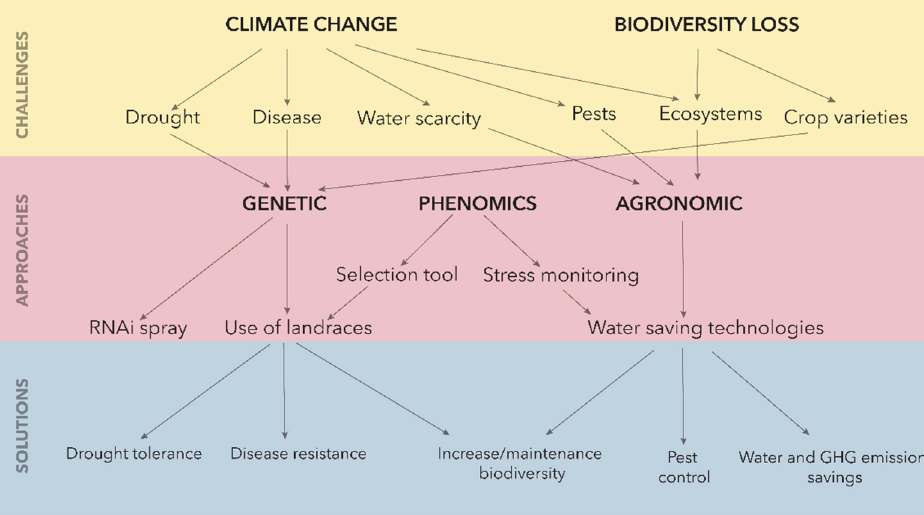
Figure 1. Main challenges, approaches, and proposed solutions of this review.